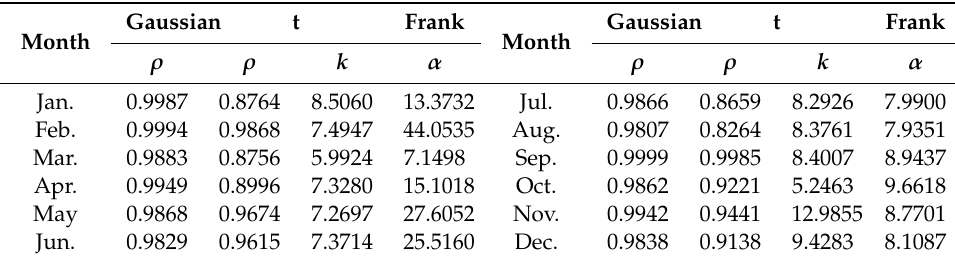
Table 4. Parameter estimation of di ff erent Copula functions.